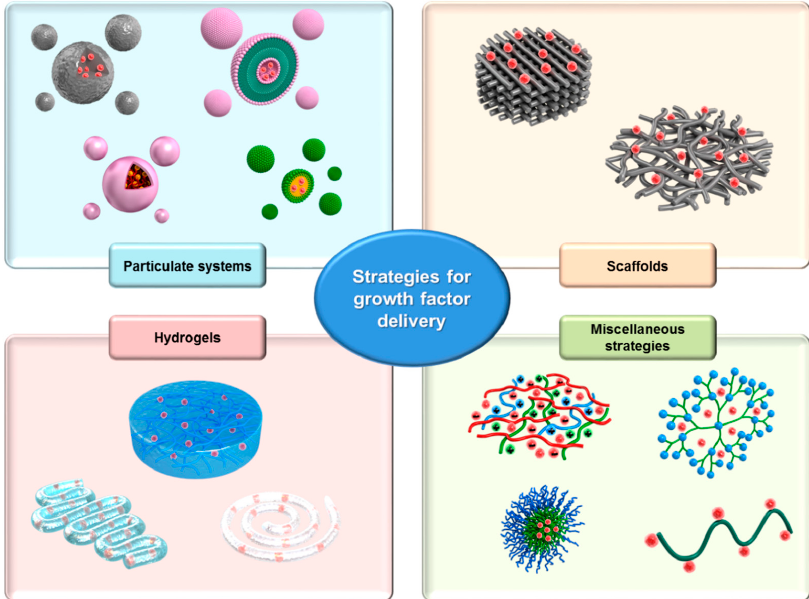
Figure 2. Schematic illustration of growth factor-loaded drug delivery systems (DDSs) for enhanced wound healing. DDSs were classified according to their matrix structures, i.e., particulate systems, scaffolds, hydrogels, and miscellaneous strategies.